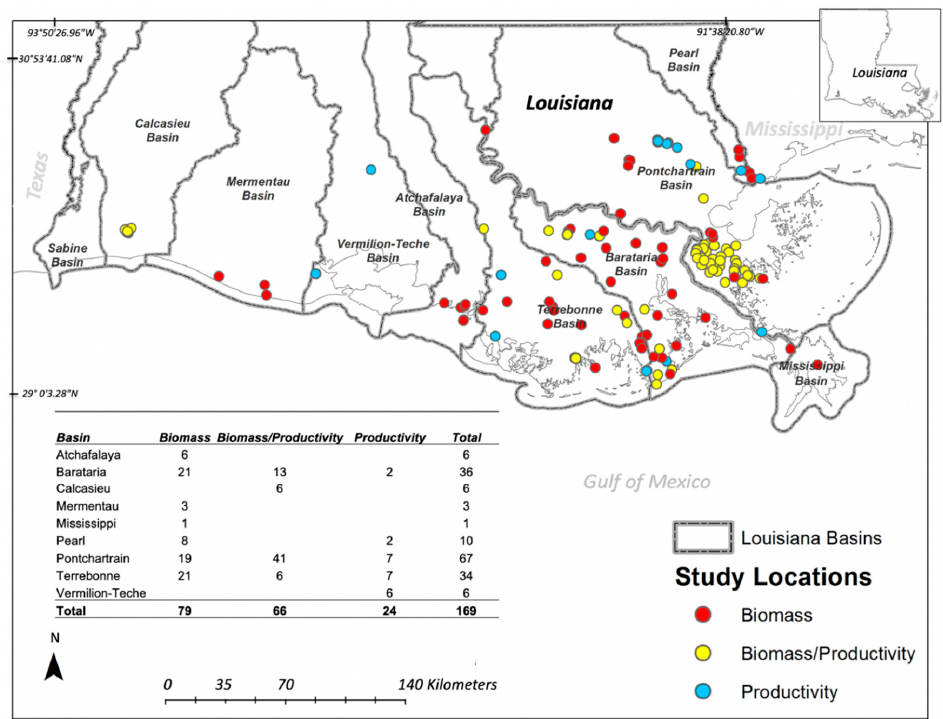
Figure 1. Location of wetland vegetation biomass and productivity studies in different basins in the Chenier and Delta Plains from 1976–2015 across coastal Louisiana. Inset table shows the number of studies per basin.